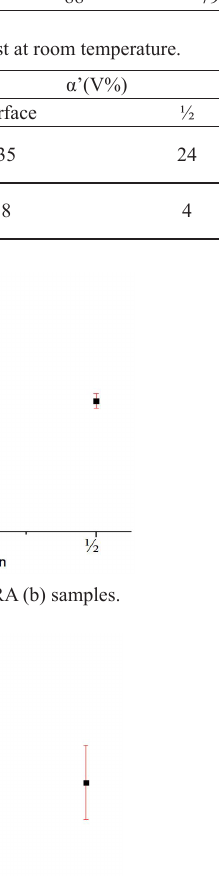
Table 2. Martensite volume of as-received samples and after rolling at room temperature. Samples as- received